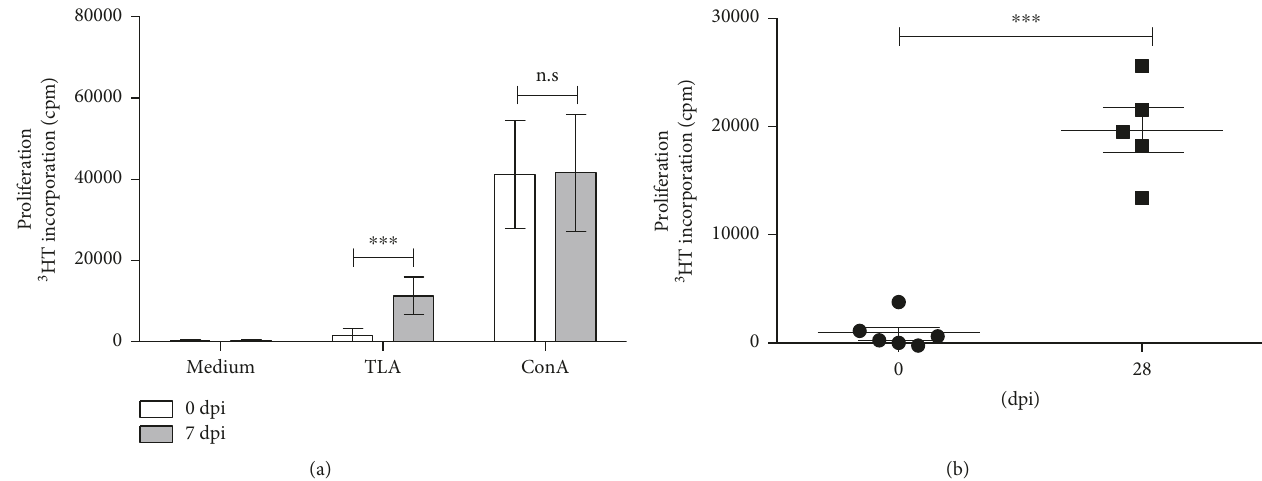
Figure 1: Toxoplasma antigen-speci fi c T cell proliferation in cells from T. gondii -infected animals. (a) 1.5 × 10 5 PBMC/well from 6 pigs before infection and 7 dpi were stimulated in triplicate with TLA or ConA for 4 days. Thereafter, 3 H-thymidine was added for 18 – 24h. Data are given as mean cpm ± SD from 6 individuals. (b) TLA-speci fi c cell proliferation from uninfected and infected (28 dpi) animals. Each dot represents the result of one individual. Signi fi cant di ff erences are marked with asterisks. Data are given as mean cpm ± SD from 5 individuals; (n.s. =not signi fi cant; ∗∗∗ p ≤ 0 0001 ).